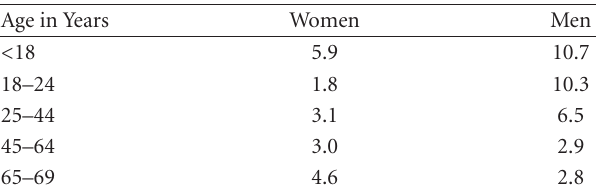
Table 3: Age and gender specific fracture incidence rates in the US population. National Center for Health Statistics, National Health Interview Survey (NHIS) 1994.